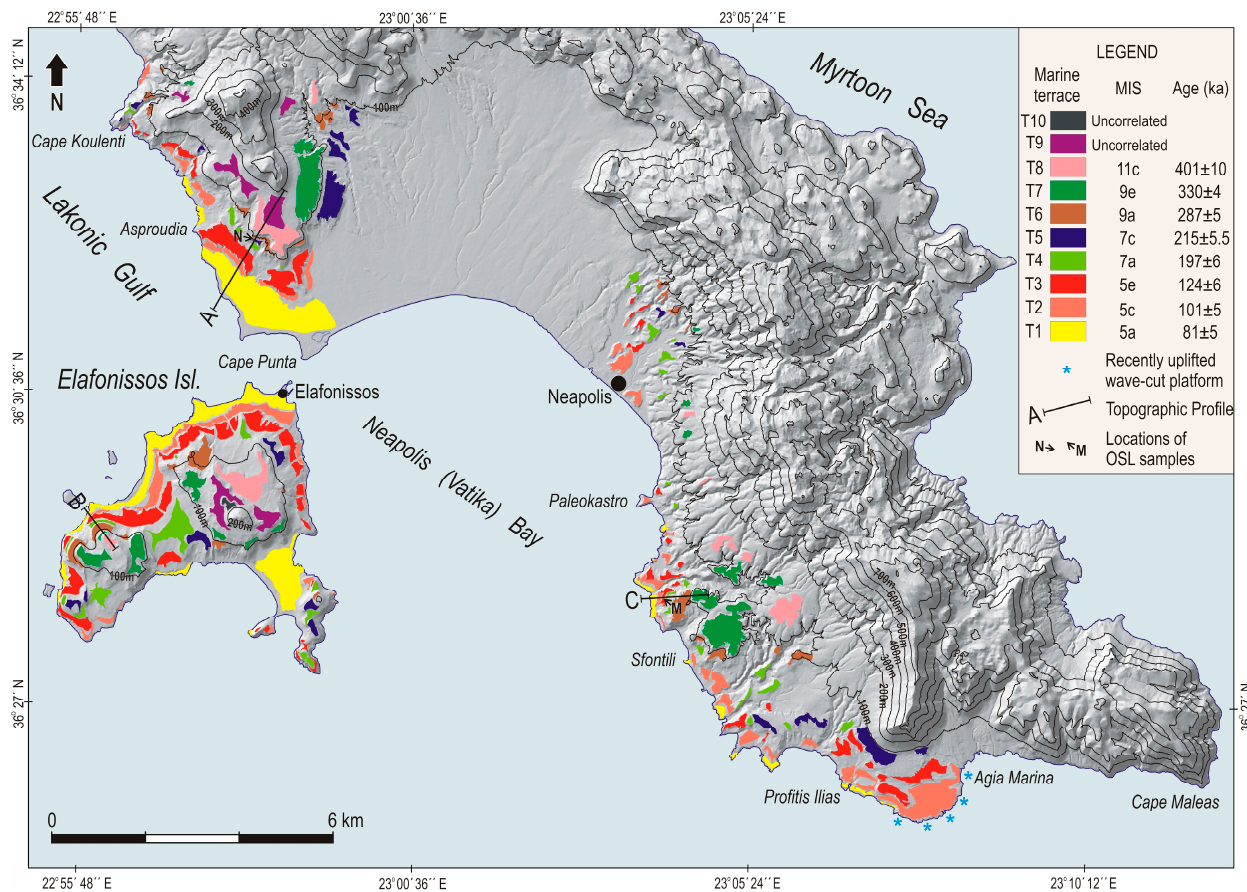
Figure 4. Geographic distribution of the uplifted marine terraces of the broader Neapolis area, southeastern Peloponnese. The location of the topographic profiles, as well as the location of the OSL samples, are also depicted.